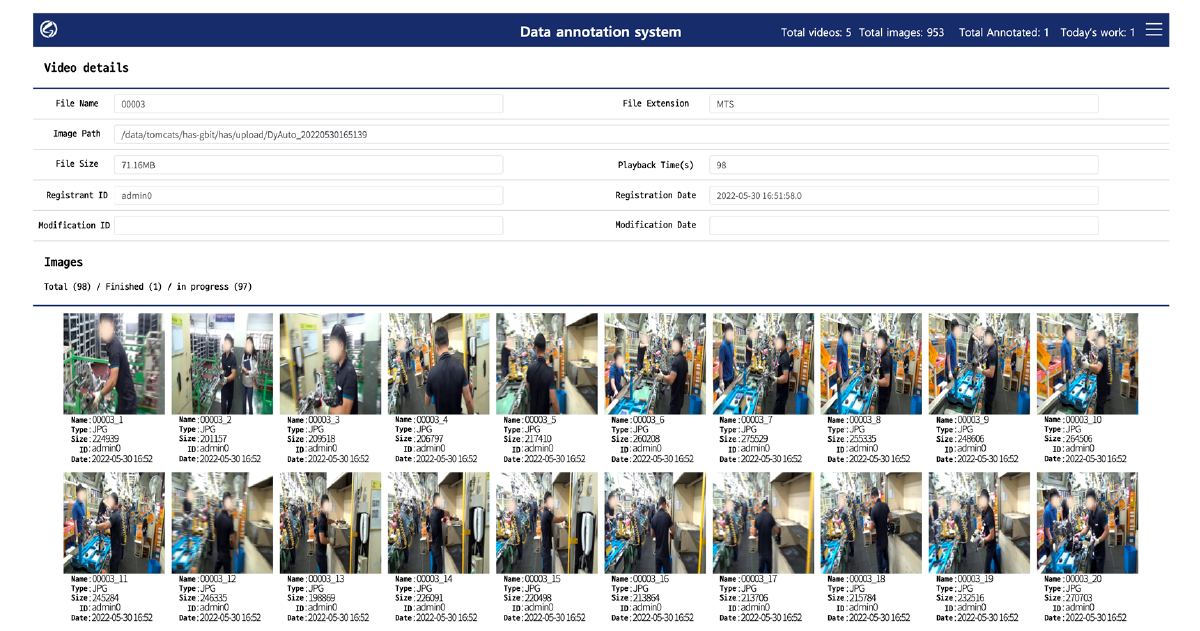
Figure 6. Images sampled at 1 s intervals by the web browser-based data annotation system.